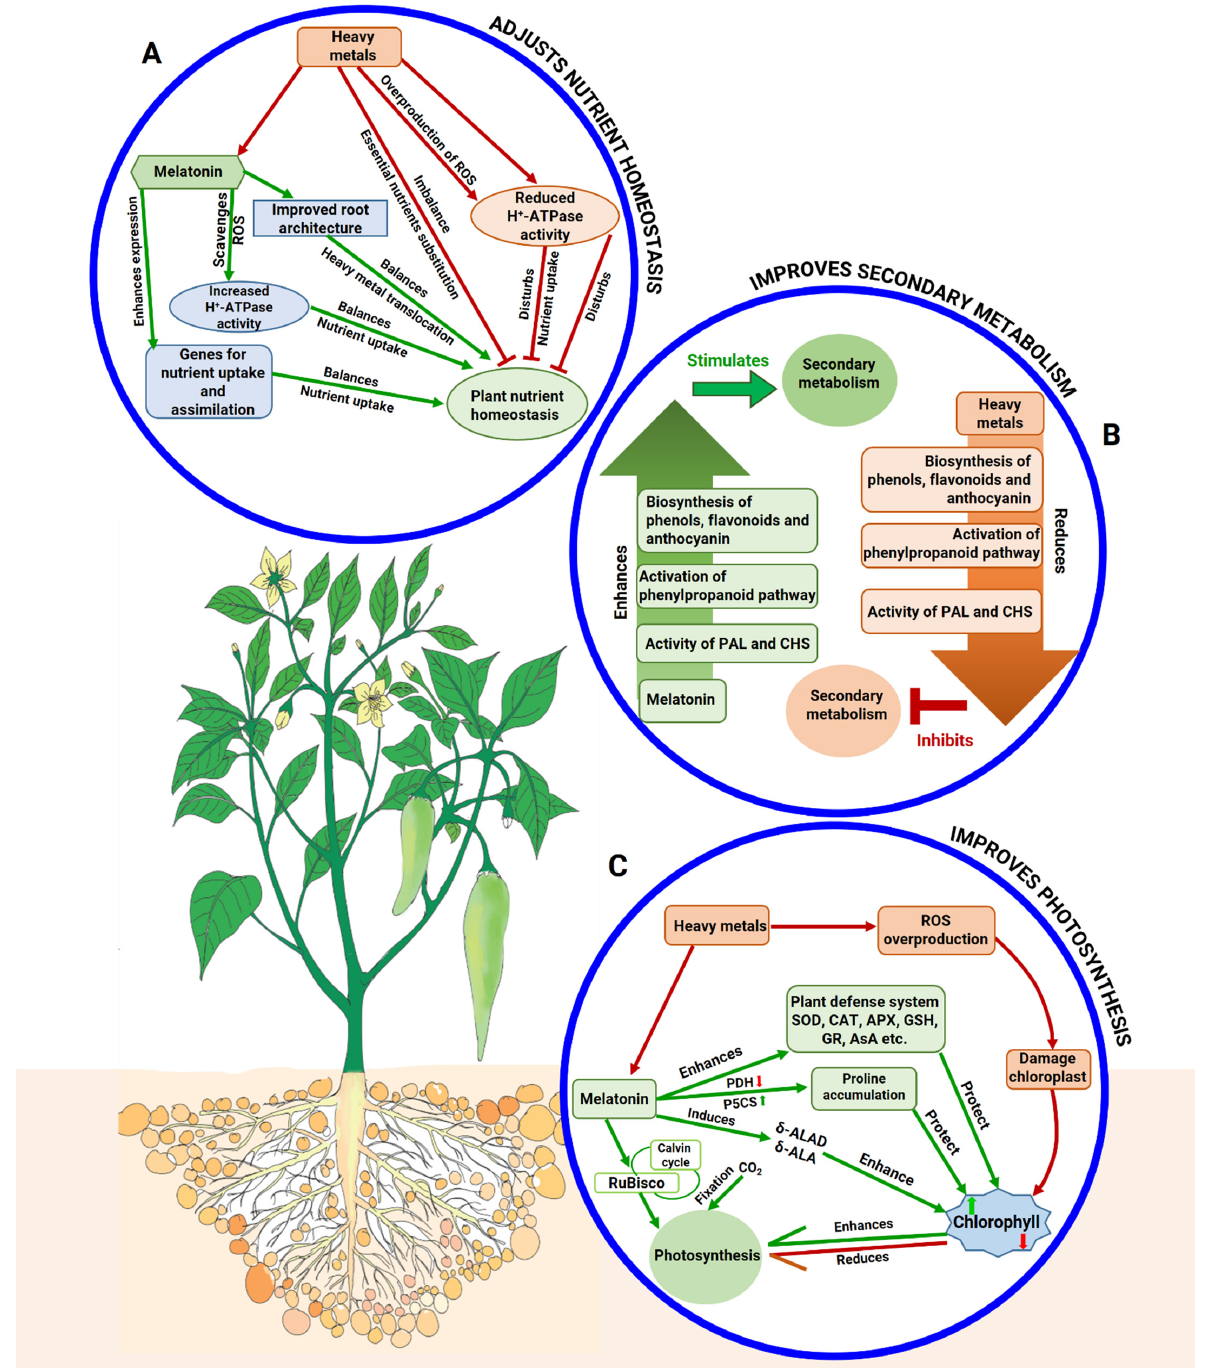
Figure 3. Schematic diagram showing MT-mediated ( A ) maintenance of nutrient homeostasis, ( B ) improvement in secondary metabolism, ( C ) enhancement in photosynthesis in plants under different HM stresses. ( A ) ROS: reactive oxygen species, H + -ATPase: proton pump ATPase. ( B ) PAL: phenylalanine ammonia-lyase, CHS: chalcone synthase. ( C ) GOx: glycolate oxidase, CO 2 : carbon dioxide, Chl: chlorophyll, CA: carbonic anhydrase, δ -ALA: δ -aminolevulinic acid and δ -ALAD: δ -aminolevulinic acid dehydratase, Pro: proline, P5CS: ∆ 1-pyrroline-5-carboxylate synthetase activity, PDH: proline dehydrogenase, SOD: superoxide dismutase, CAT: catalase, APX: ascorbate peroxidase, GSH: reduced glutathione, GR: glutathione reductase, AsA: ascorbic